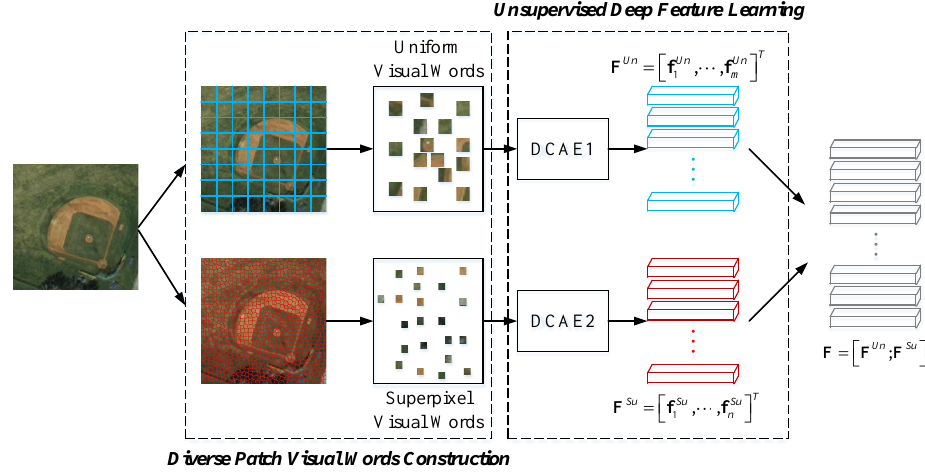
Figure 6. Framework of the proposed patch based deep descriptor